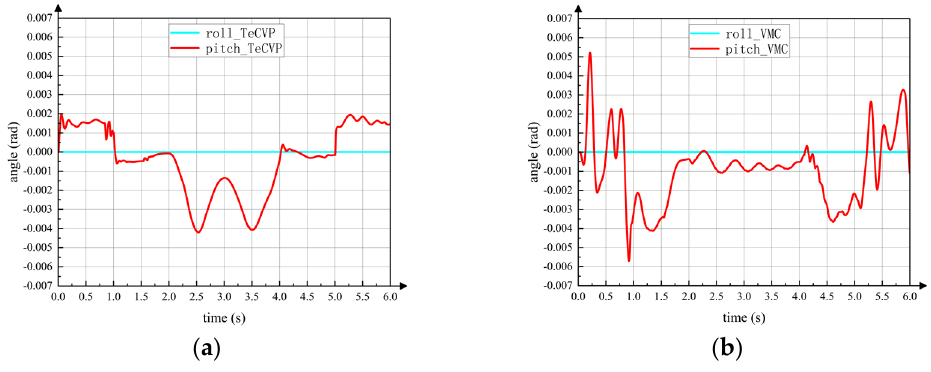
Figure 13. Posture of torso during switching motion ( a ) TeCVP; ( b ) VMC.